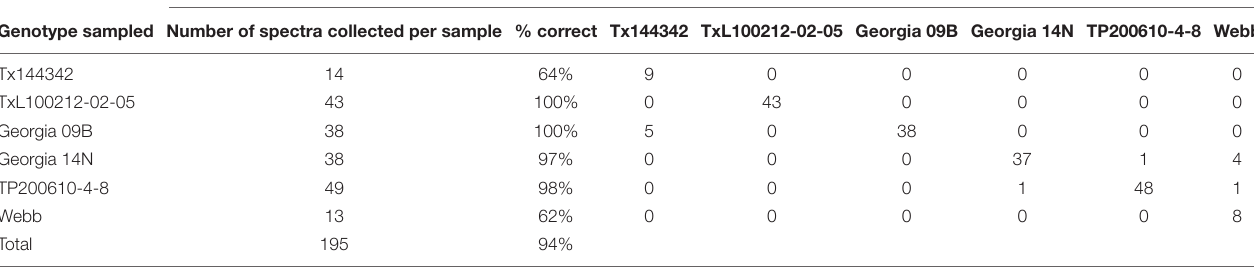
Predicted genotype